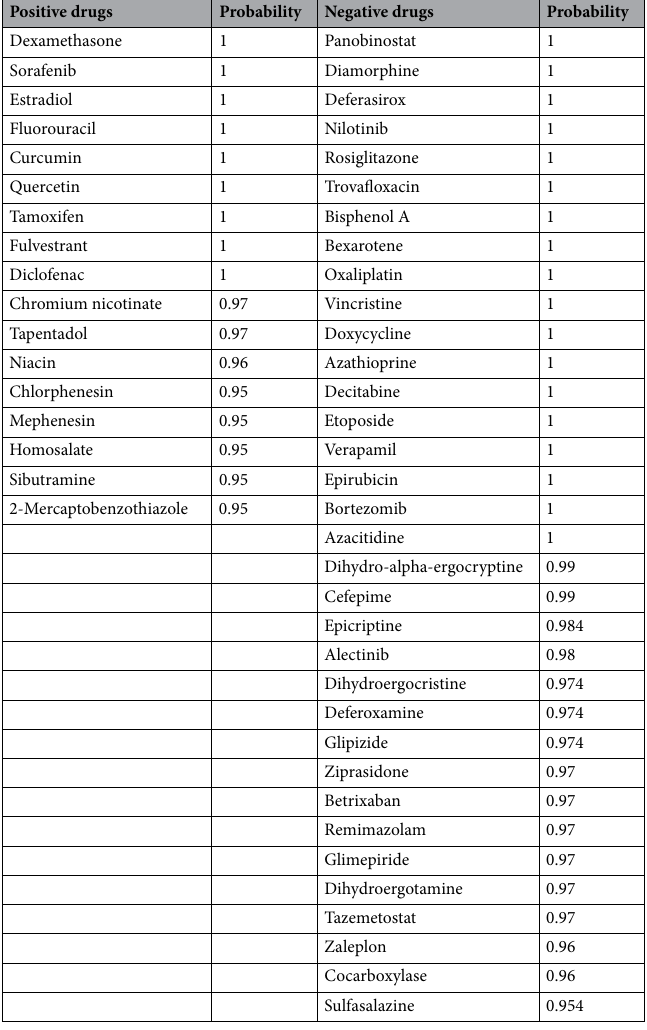
Table 8. Final selected FDA approved drugs with positive and negative effects. The final FDA-approved negative and positive drugs are listed in this table. Positive drugs are suggested for repurposing. Negative drugs, on the other hand, have been introduced as warning drugs that may disrupt the expression of common lncRNAs and significantly increase the negative effects of both diseases